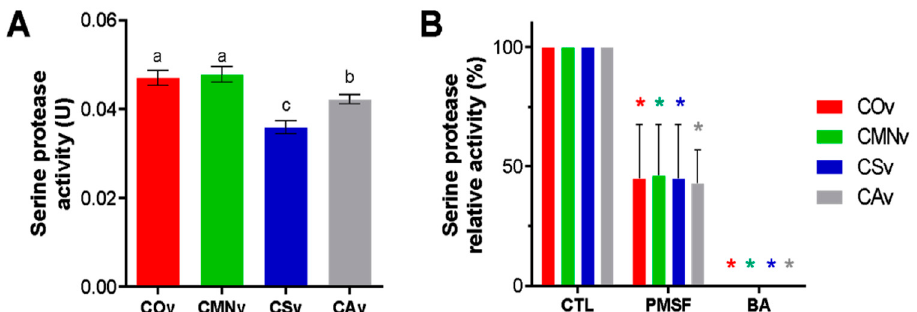
Figure 5. Serine protease activity for Crotalus venoms using L-TAME and inhibitor modulation. ( A ) Serine protease activity for C. ornatus (COv), C. m. nigrescens (CMNv), C. scutulatus (CSv), and C. atrox (CAv). 5 µ g of each venom were incubated with 1.0 mM L-TAME. Enzymatic activity is expressed in serine protease activity units. Statistical di ff erence between venom samples is denoted with di ff erent letters ( p < 0.05). ( B ) Inhibitor modulation in serine protease activity for all venoms. 5 µ g of each venom were preincubated with 5 mM PMSF or EDTA for 10 min before substrate addition. Enzymatic activity is expressed in protease activity percentage in comparison to CTL. Data are presented as the mean of at least three independent experiments with its respective standard error, statistically significant di ff erence ( p < 0.05) with respect to control for each venom is represented with an asterisk (*).